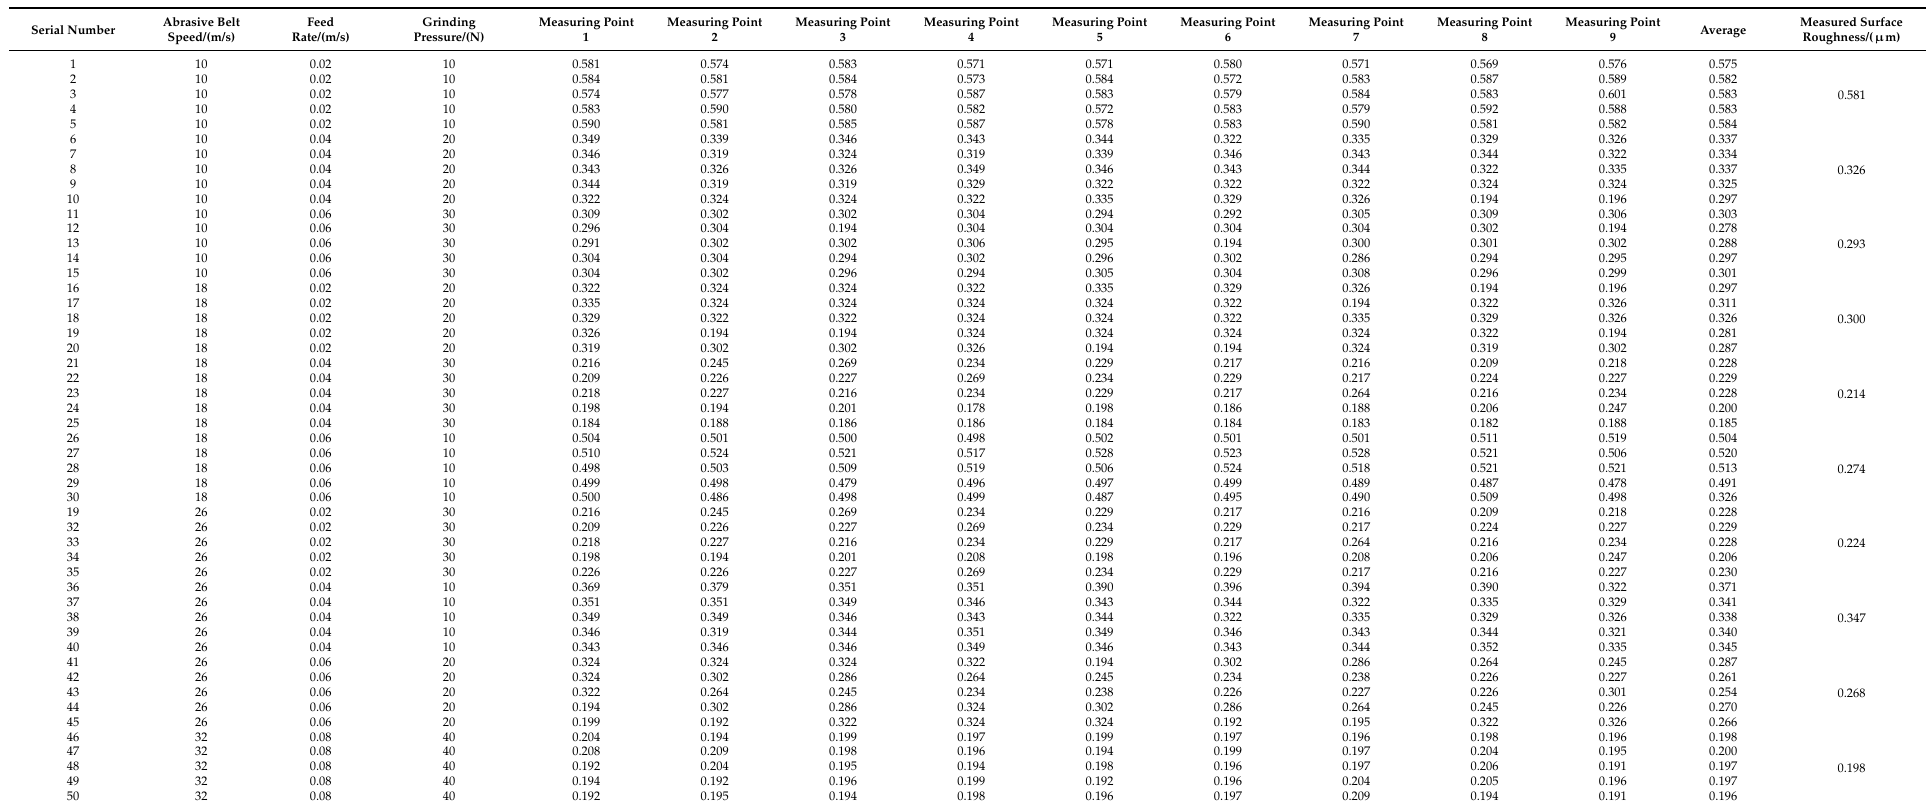
Table A1. Complete data of the processing parameter